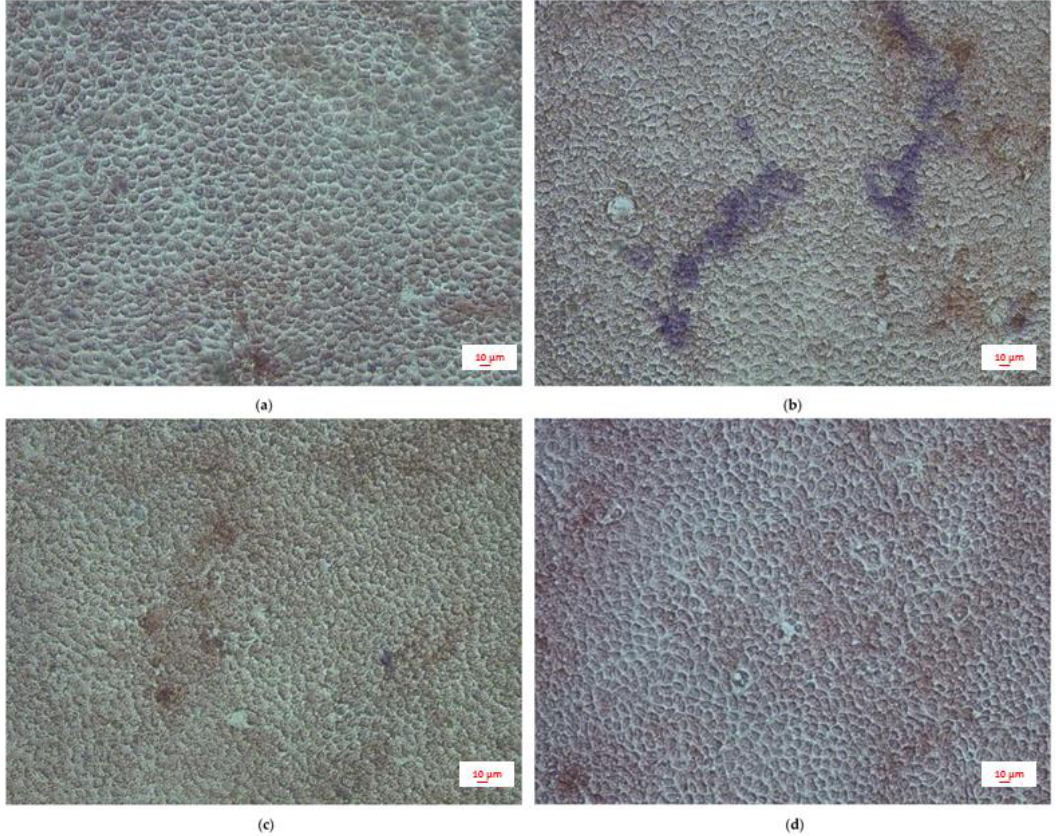
Figure 8. PBMC adhesion assay: ( a ) control, ( b ) LPS 500 ng/mL, ( c ) CUR 1 µg/mL + LPS 500 ng/mL, ( d ) BOS 1 µg/mL + LPS 500 ng/mL. Caco-2 cells were preincubated with CUR and BOS for 24 h and